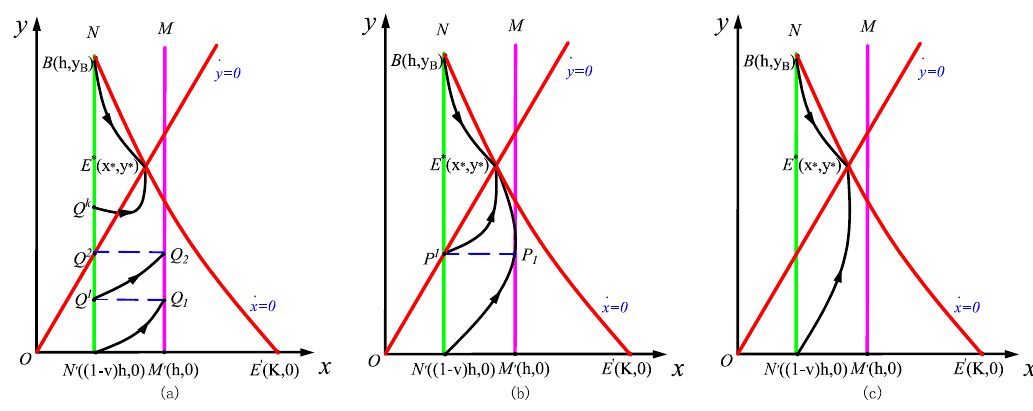
Figure 3. System (7) has no order-one periodic orbit if 0 < ( 1 − v ) h < x ∗ < h holds. ( a ) The trajectory f ( N (cid:48) , t ) intersects with impulse set M ; ( b ) the trajectory f ( N (cid:48) , t ) and impulsive set M are tangent; ( c ) the trajectory f ( N (cid:48) , t ) will have no intersection point with impulse set M